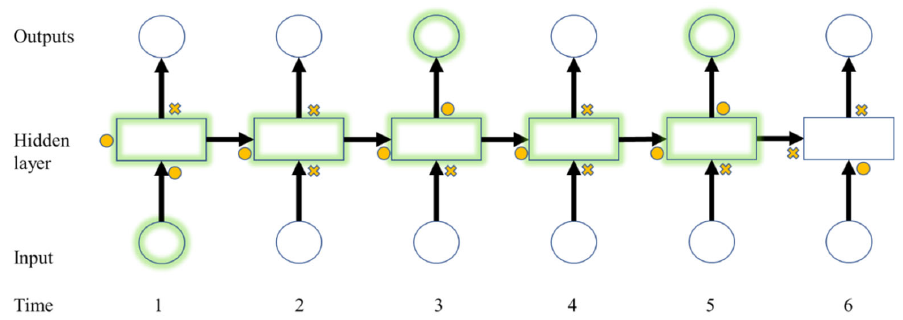
Fig. 8. LSTM neural network consisting of the unrolled LSTM cells